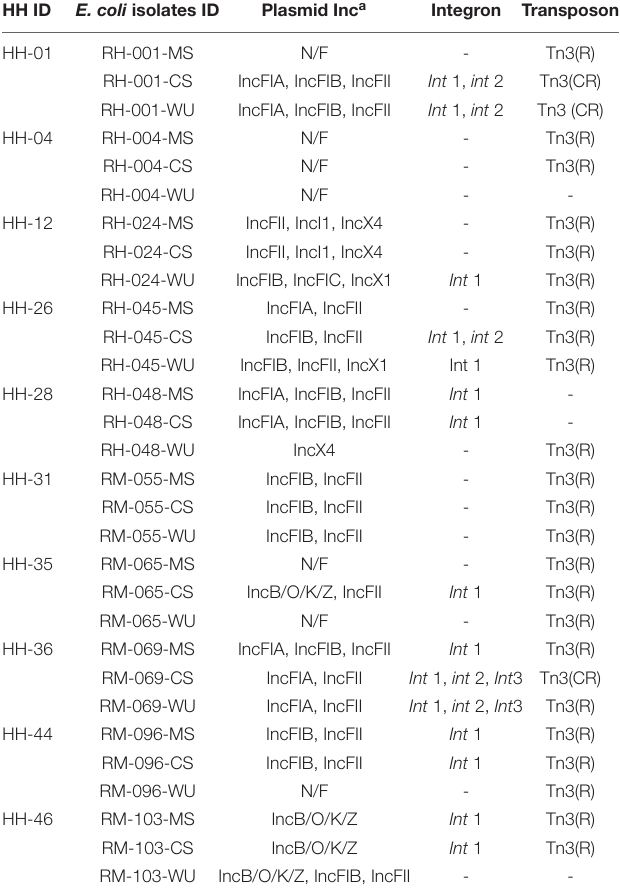
TABLE 2 | Distribution of mobile genetic elements in 30 E. coli isolates of 10 households. HH ID E. coli isolates